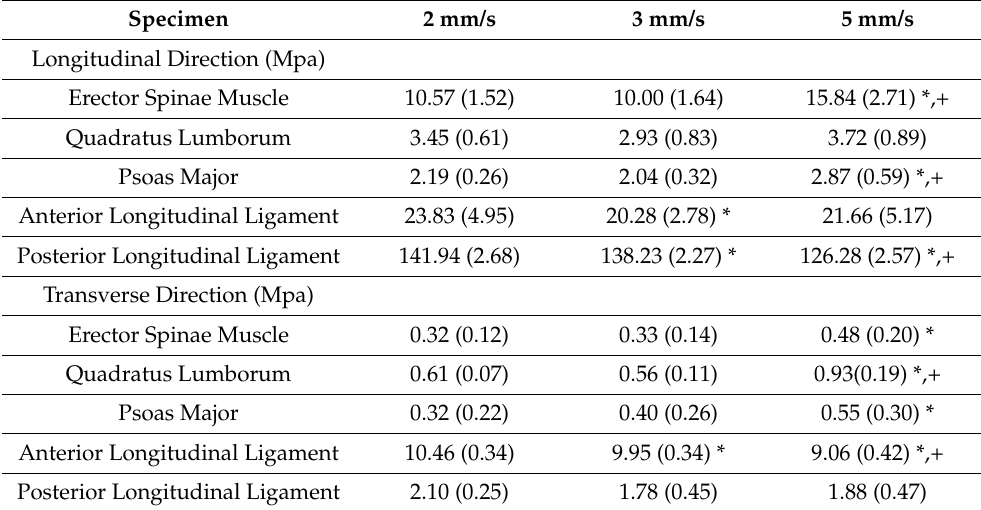
Table 2. Mean (std) of Young’s Modulus of each